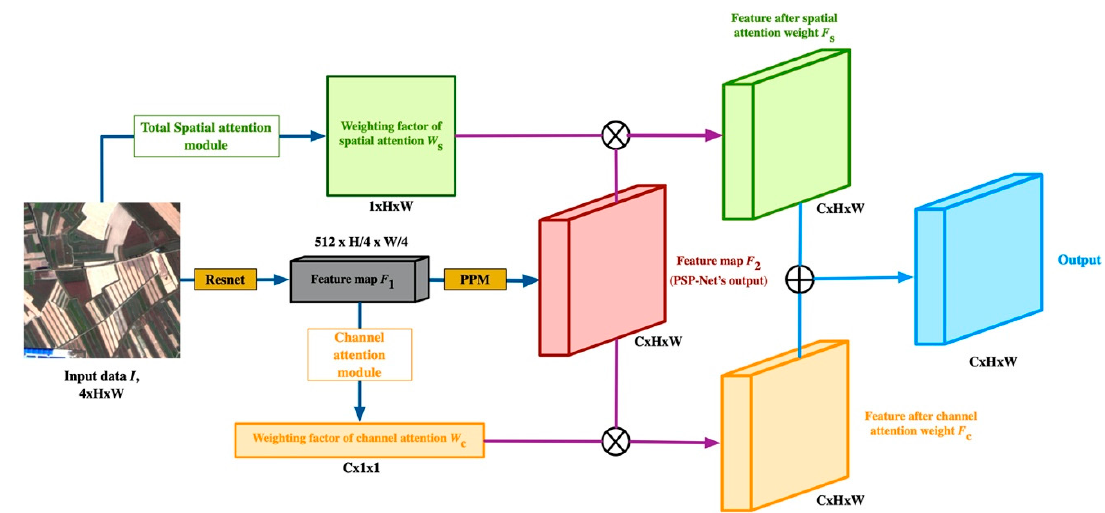
Figure 2. The overall DPA-PSP-Net framework. DPA: Dual Path Attention.